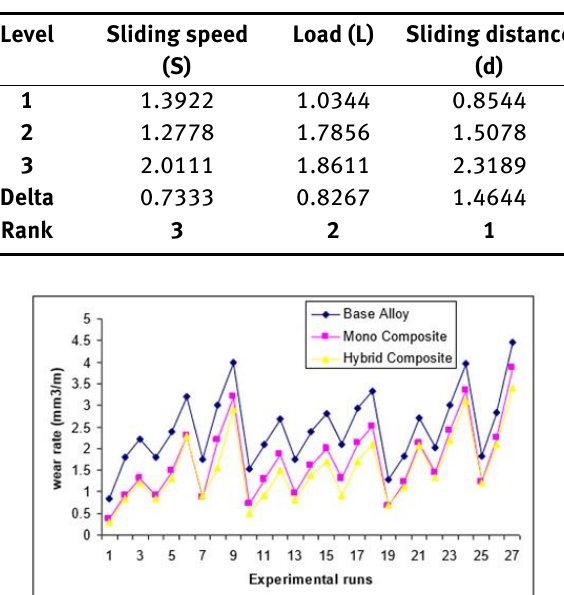
Table 9: Response table for means hybrid composite (Al2219+8%